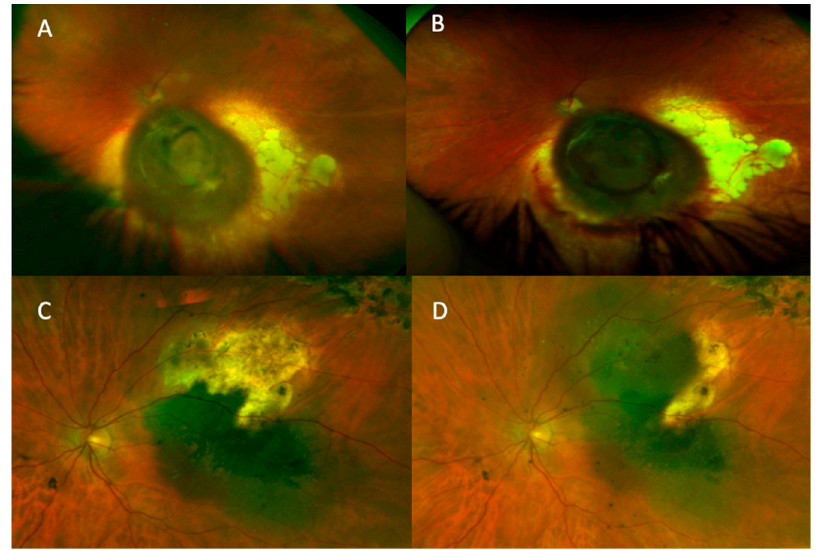
Figure 1. Tumour recurrences as seen in wide-field colour photographs. ( A , B ) demonstrate how increased thickening of the tumour can be observed with colour photography. ( C , D ) demonstrate lateral tumour extension.